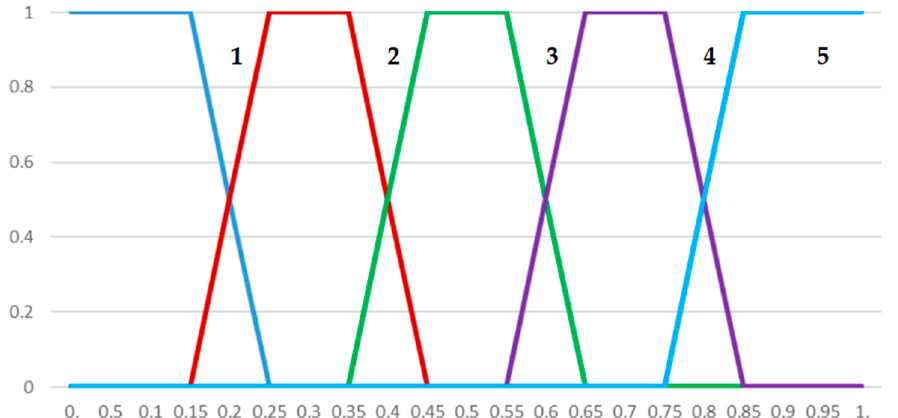
Figure 2. Membership functions for criteria importance terms. 1—extremely low, 2—low, 3—medium, 4—high, 5—very high.